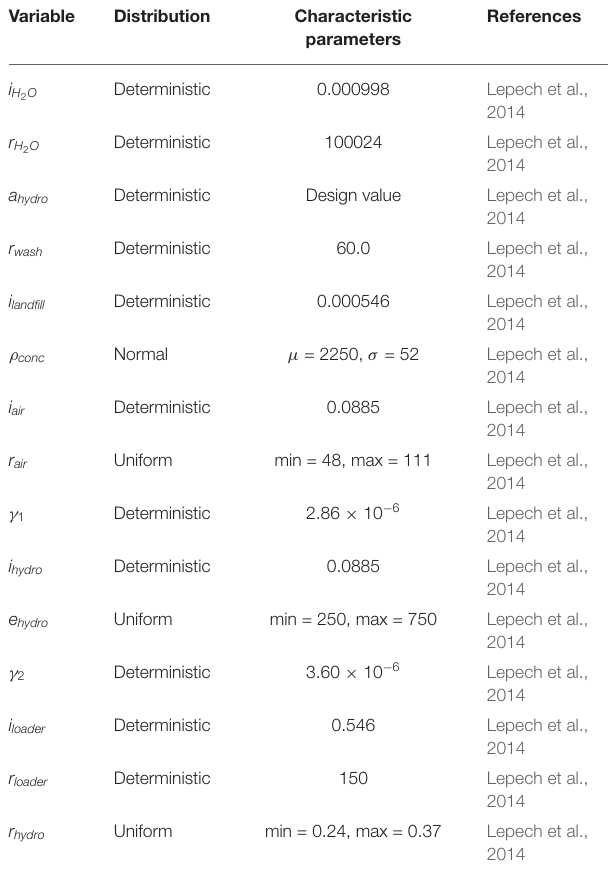
TABLE 3 | Hydrodemolition environmental impact modeling variables, distributions, and